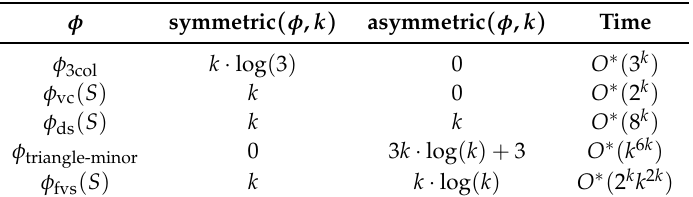
Table 2. The table gives an overview of formulas φ used within this paper, together with the values symmetric ( φ , k ) and asymmetric ( φ , k ) , as well as the precise time our algorithm will require to model check an instance for that particular